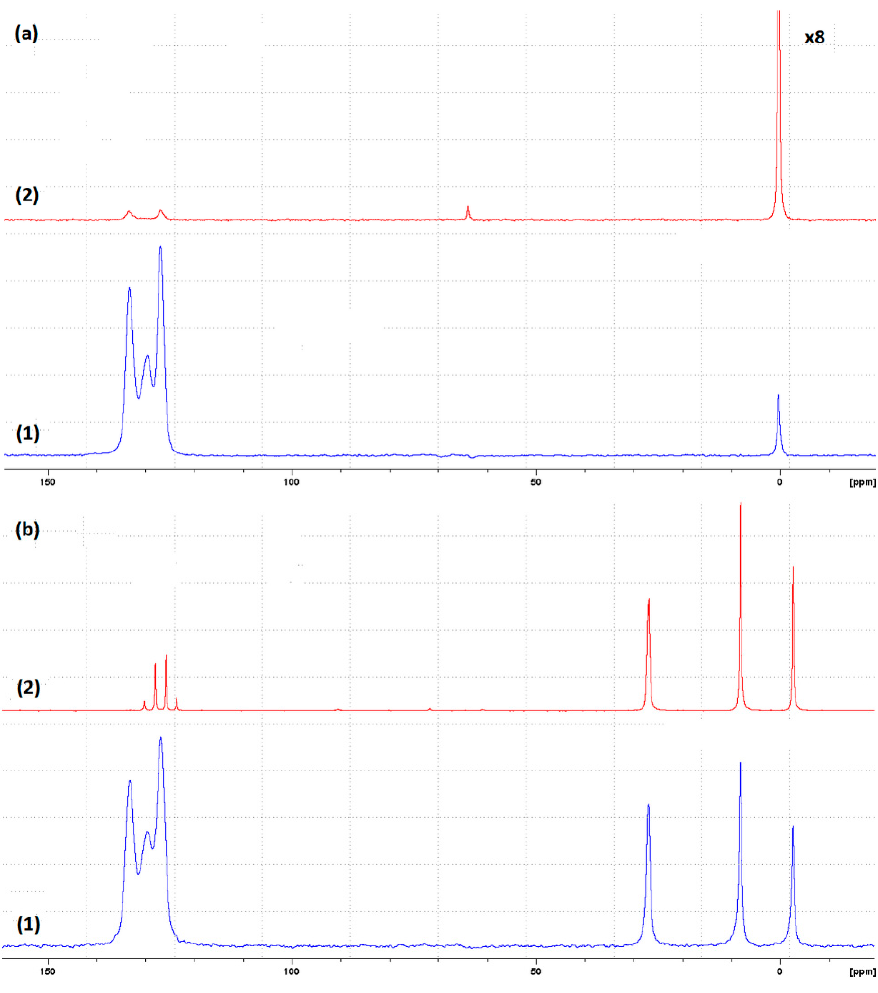
Figure 3. 13 C CP/MAS (1), and Hahn echo NMR experiment (2) of BCPs I ( a ) and II ( b ).